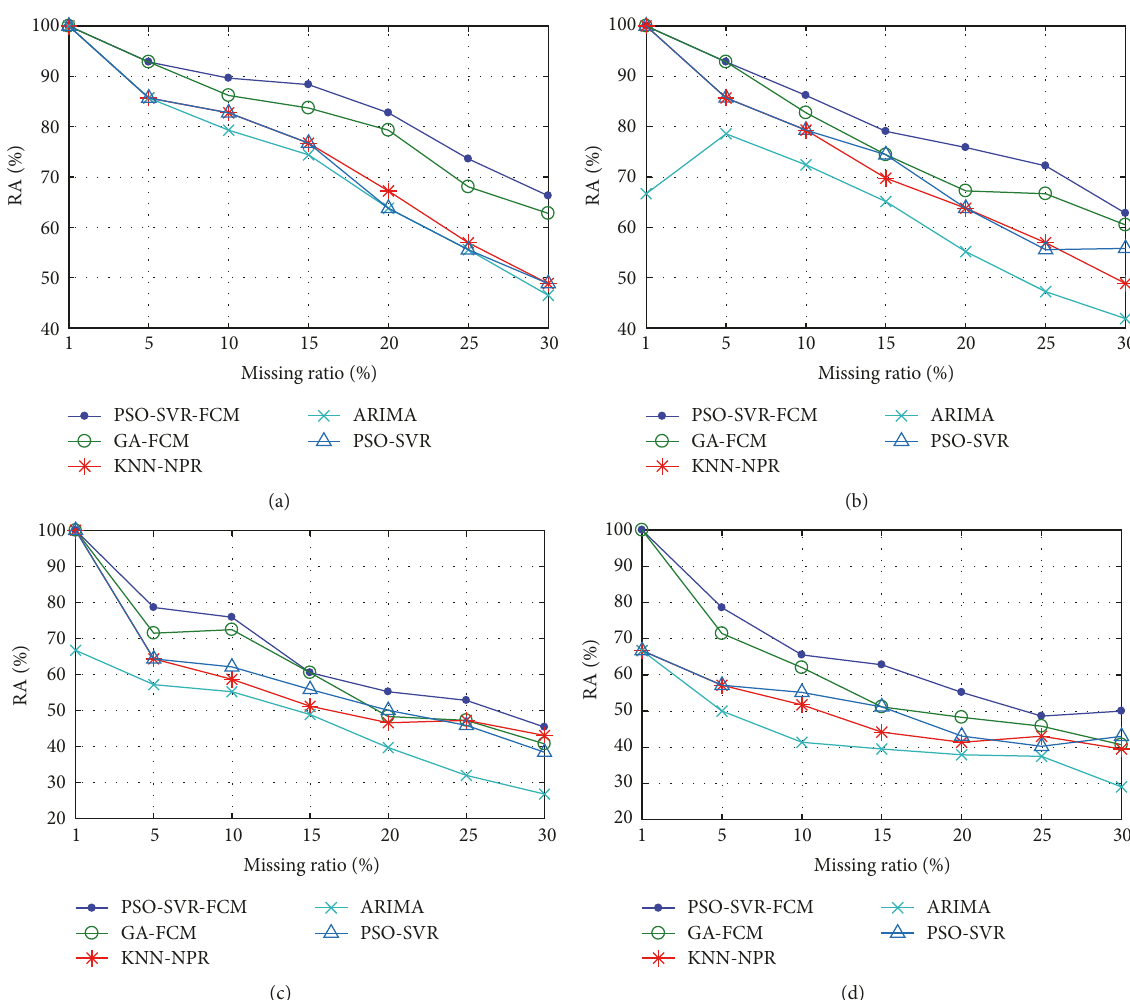
Figure 15: The RA curve of each method for comparison in MR pattern, using the traffic data collected from the detectors (a) NBXX13 (2) , (b) NBXX11 (4) , (c) DC00004964(E2), and (d)